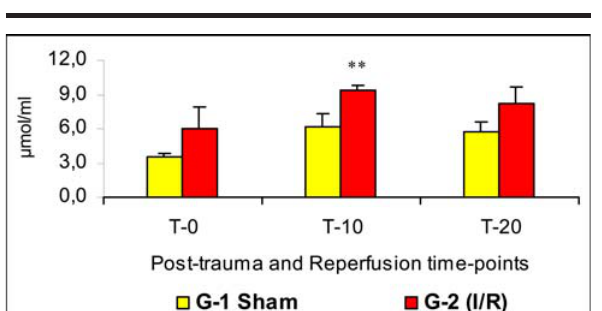
FIGURE 5 - Blood pyruvate concentrations (n=6) in G-1 and G-2 rats. Values are expressed as mean±S.E.M.